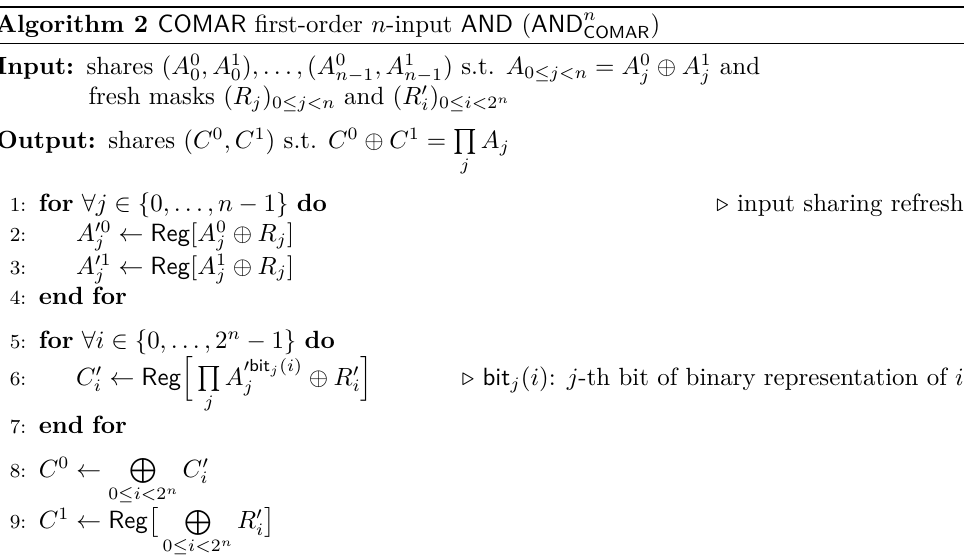
Figure 4: COMAR first-order 2-input AND gate ( AND Algorithm 2 COMAR first-order n -input AND ( AND n